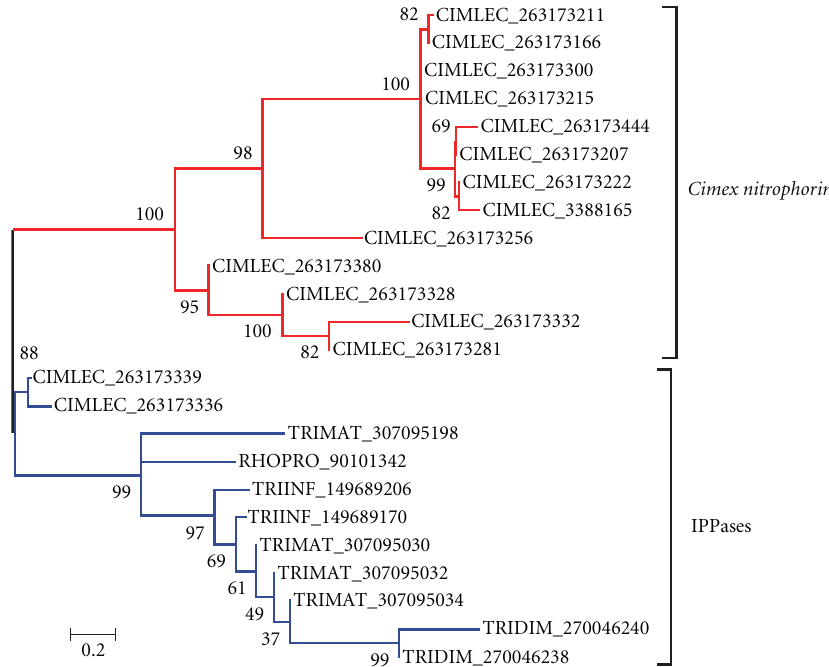
Figure 1: Phylogram of the inositol triphosphate phosphatase family of Cimicomorpha. The sequences are named with the first 3 letters of the genus name, followed by the first 3 letters of the species name, followed by their GenBank GI accession number. The sequences were aligned by Clustal, and the neighbor-joining bootstrapped phylogram was obtained with the MEGA package with 10,000 iterations, Poisson model of amino acid substitution and pairwise amino acid comparisons using the gamma rate of amino acid substitution (gamma parameter = 1). The numbers at the nodes are the percent bootstrap support. The line at the base indicates the rate of amino acid substitution per site.